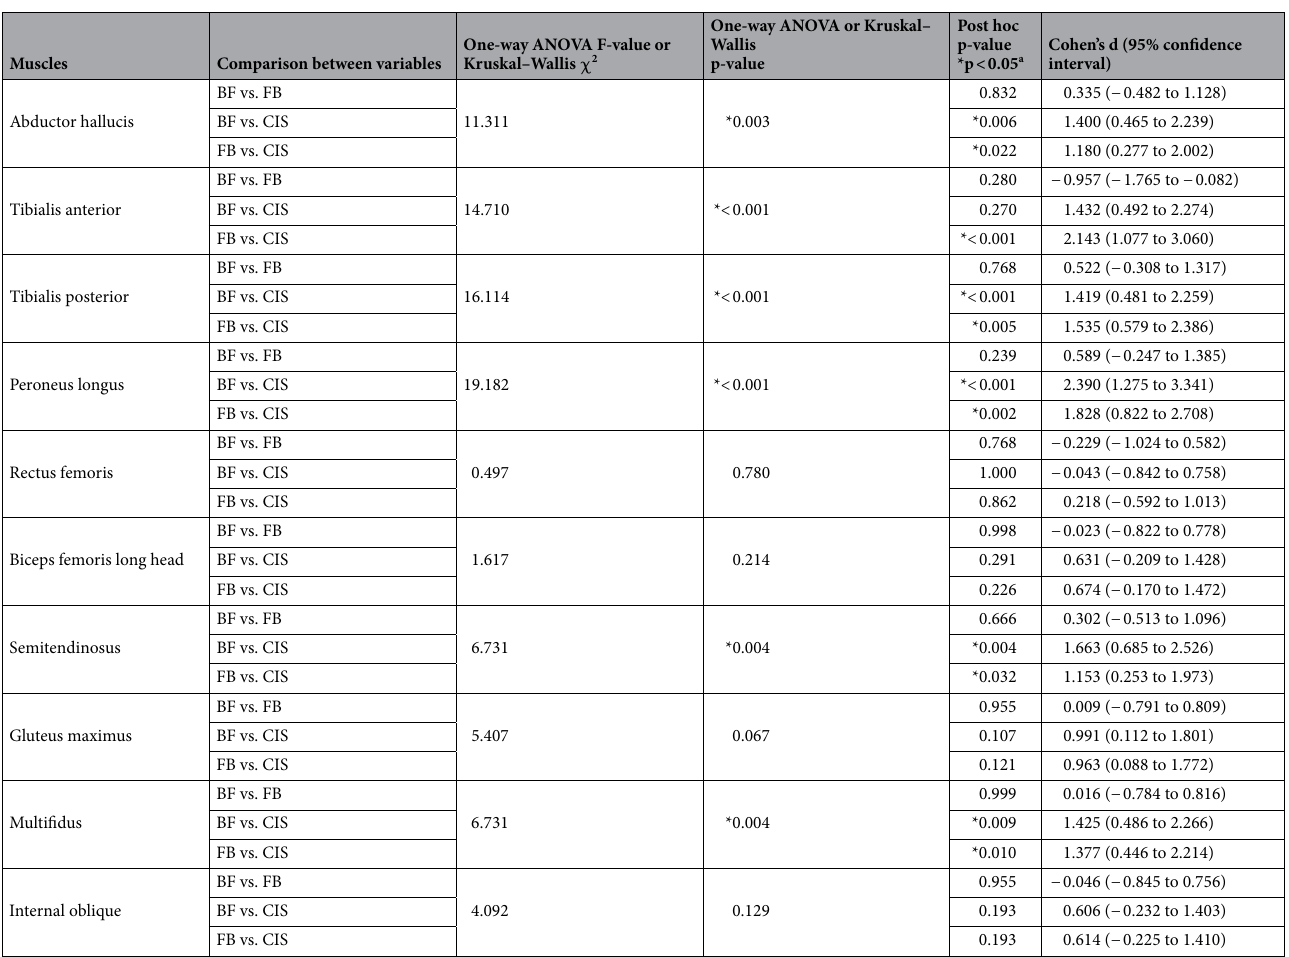
Table 3. The results of statistical analysis. FB front to back, BF back to front, CIS conventional isometric squat. a Adjusted p-value by multiplying the original p-value by